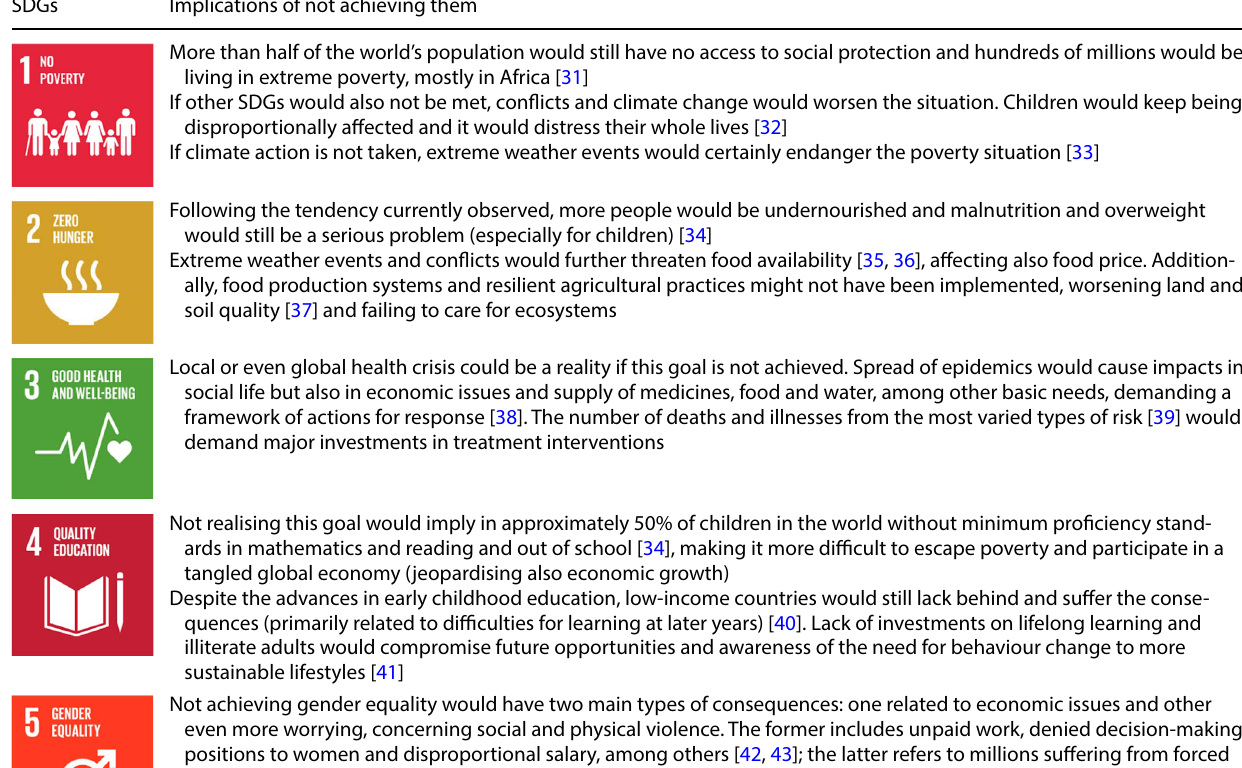
Table 2 Some of the consequences of not reaching the SDGs. Source: prepared by the authors SDGs Implications of not achieving